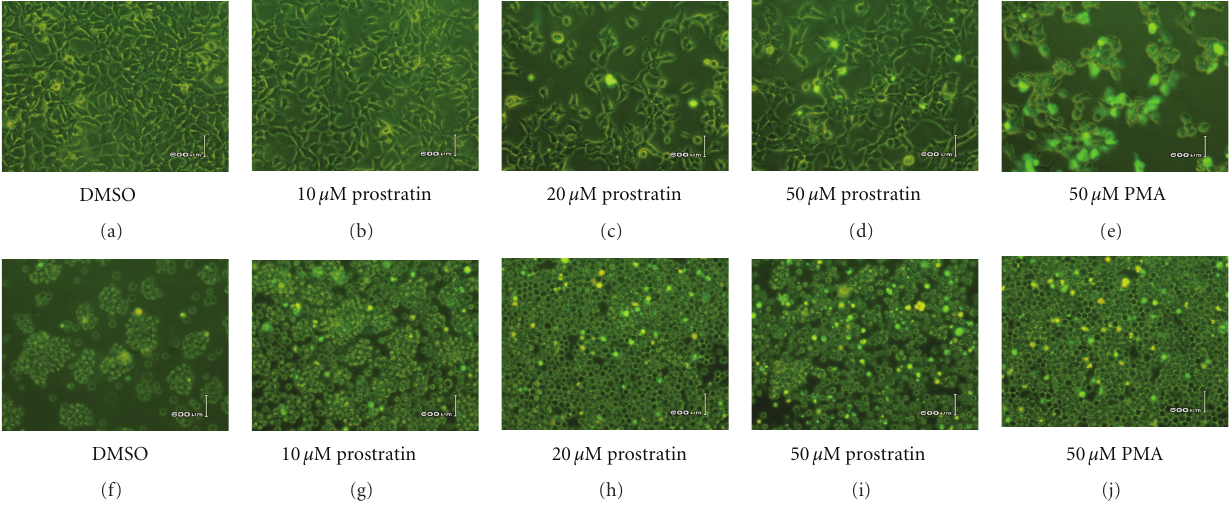
Figure 3: Morphological and apoptotic e ff ects of PMA and prostratin on select cell lines. Top panel: 293 adherent cells. Lower panel: Jurkat cells. Concentrations of prostratin at or below 10 μ M, higher than required to upregulate latent HIV-1, do not markedly alter morphogenesis or induce apoptosis. Concentrations > 10 μ M a ff ect both cellular